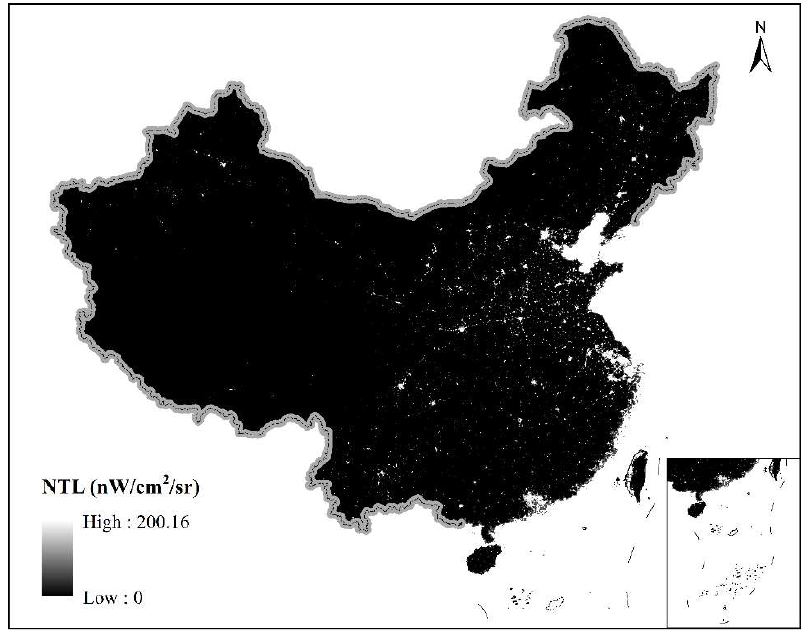
Figure 2. Nighttime light image of China from 2010.